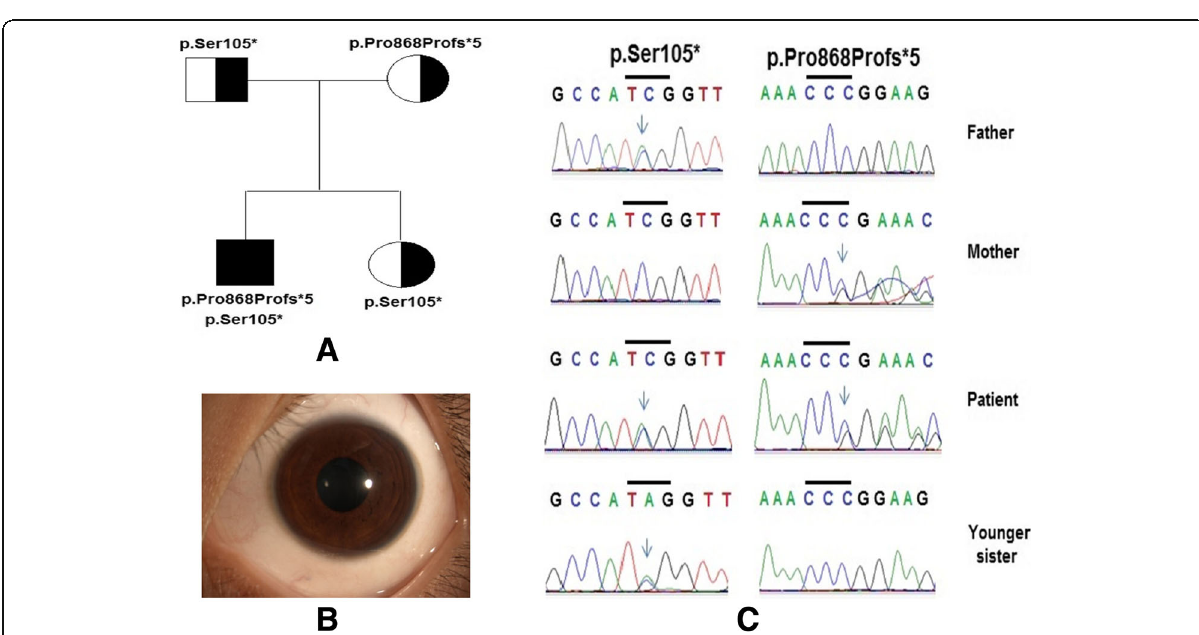
Fig. 3 Mutations of the ATP7B gene were identified by sequencing in patient 3 and his family. Pedigree of patient ’ s family ( a ), the Kayser-Fleischer ring around the cornea of patient ’ s eye ( b ) and mutations ( c ) of ATP7B gene were identified, including a compound heterozygous mutation p.Ser105* and heterozygous frameshift mutation